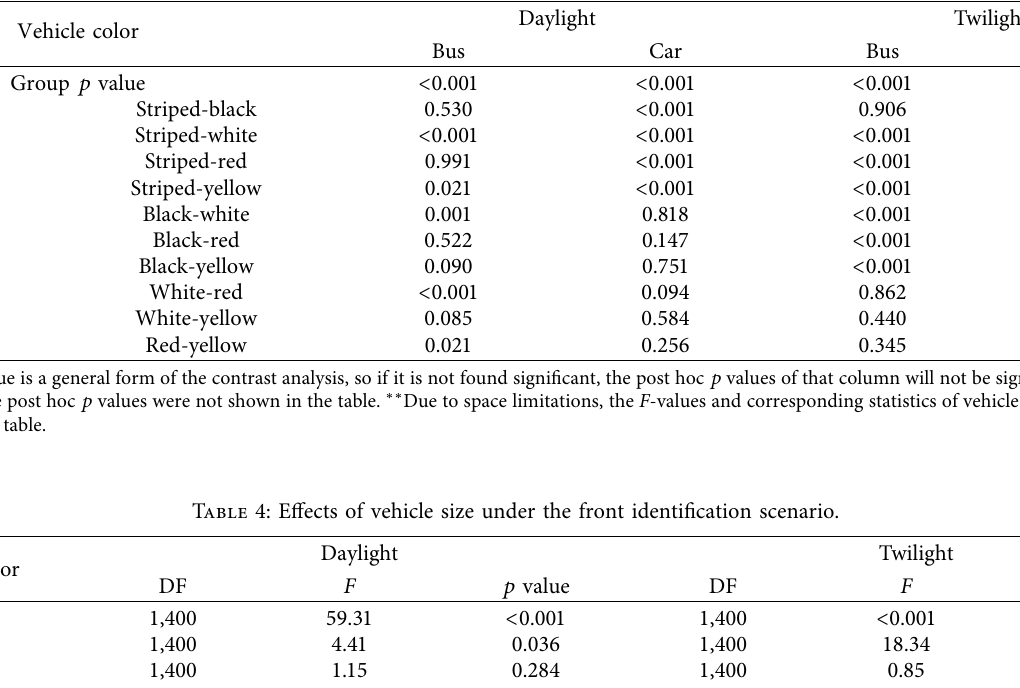
Table 3: The effects of vehicle color under the front identification scenario.